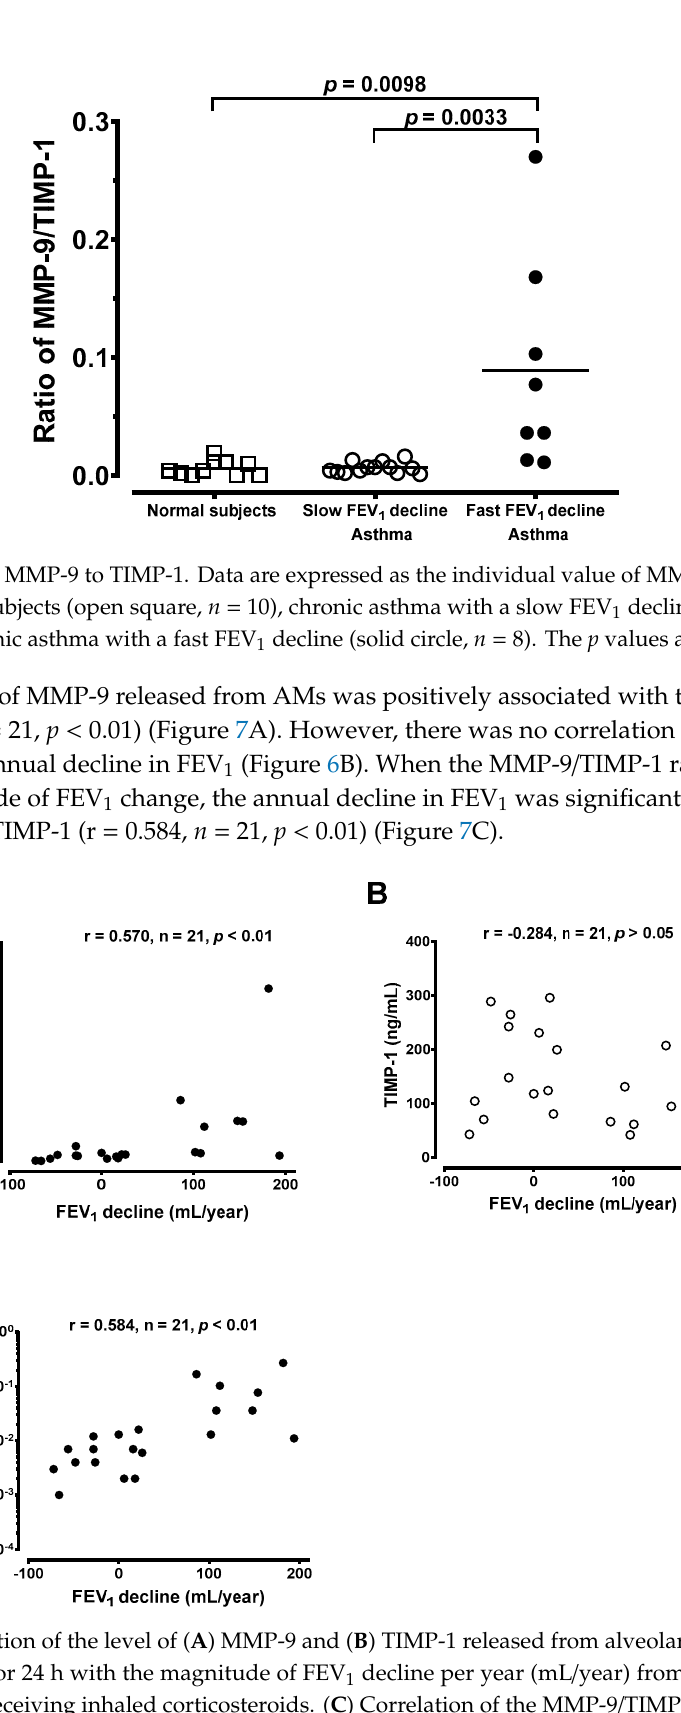
Figure 7. Correlation of the level of ( A ) MMP-9 and ( B ) TIMP-1 released from alveolar macrophages (AMs) cultured for 24 h with the magnitude of FEV 1 decline per year (mL / year) from patients with chronic asthma receiving inhaled corticosteroids. ( C ) Correlation of the MMP-9 / TIMP-1 ratio in 24 h AM culture with the magnitude of FEV 1 decline per year over 5 years from patients with chronic asthma receiving inhaled